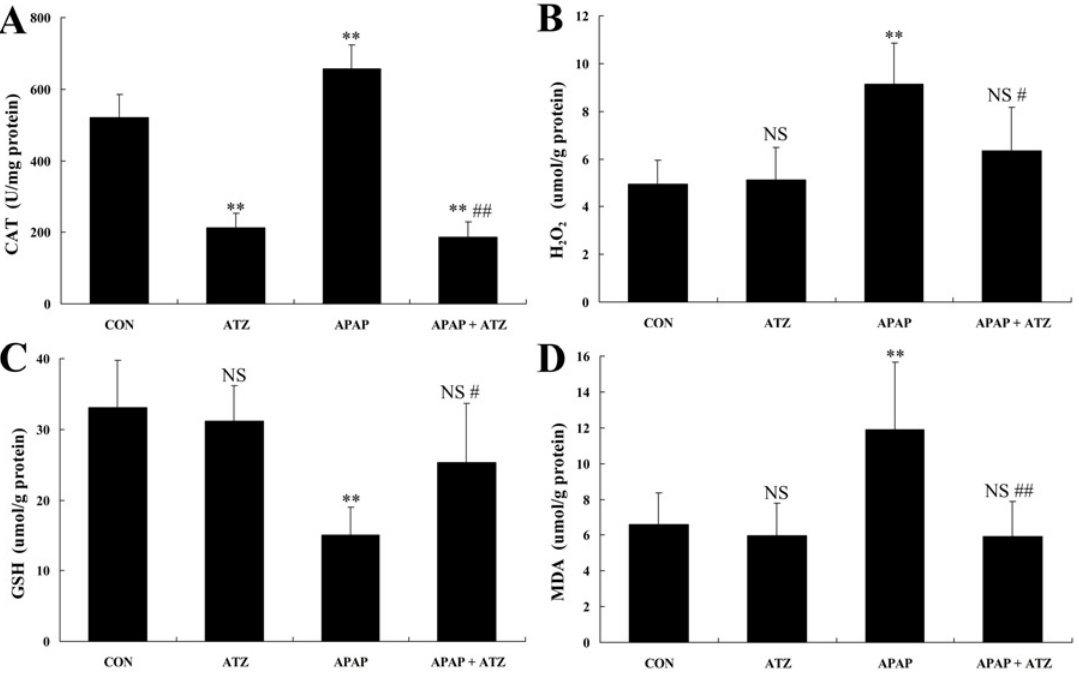
Fig 4. Pretreatment with ATZ suppressed CAT activities, H 2 O 2 contents, GSH contents and MDA contents in the liver of APAP exposed mice. Hepatic CAT activities (A), H 2 O 2 contents (B), GSH contents (C) and MDA contents (D) were determined at 8 h after APAP exposure. Data were expressed as mean ± SD, n = 8. NS P > 0.05, ** P < 0.01, as compared with the CON group; # P < 0.05, ## P < 0.01, as compared with APAP group.